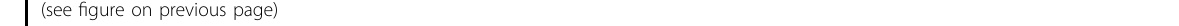
Fig. 2 TINCR promotes breast cancer cell proliferation and metastasis in vitro. A TINCR expression was examined in normal mammary epithelial cell line (MCF10A) and breast cancer cell lines by qRT-PCR assay. B Left: The relative expression of TINCR in T47D and MCF-7 cells transfected with scrambled, si-TINCR 1# and si-TINCR 2#; right: the relative expression of TINCR in T47D and MCF-7 cells transfected with empty vector and pcDNA- TINCR. C , D CCK-8 assays were performed to determine the viability of T47D and MCF-7 cells treated with si-TINCR or pcDNA-TINCR. E , F Colony formation assays were used to detect the proliferation of si-TINCR-transfected or pcDNA-TINCR-transfected T47D and MCF-7 cells. Colonies were counted and captured. G , H Proliferous breast cancer cells were displayed by EdU immunostaining assays. EdU positive cells were counted and captured (400×). I , J Transwell assays were performed to determine migration in breast cancer cells treated with si-TINCR or pcDNA-TINCR. Values are shown as the mean±s.d in three independent experiments. The mean values of two groups were compared via paired, two-tailed Student t tests. * P <0.05, ** P